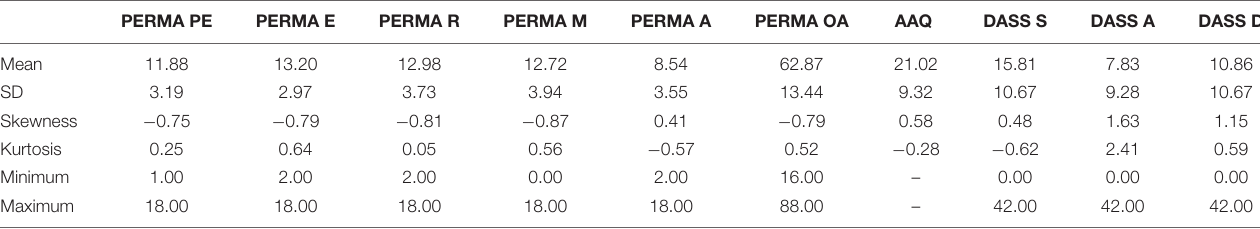
TABLE 1 | Descriptive statistics and distribution diagnostics for variables used in analyses.